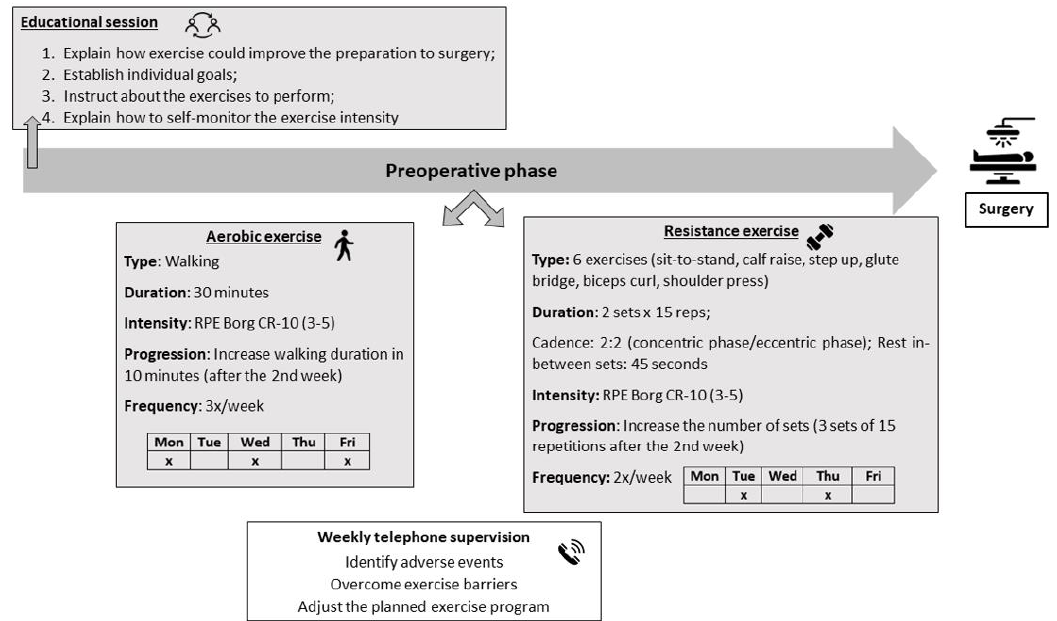
Figure 1. Preoperative home-based exercise program. Legend: RPE (rate of perceived exertion); Borg CR-10 (Borg Category Ratio-10); Mon (Monday); Tue (Tuesday); Wed (Wednesday); Thu (Thursday); Fri (Friday).